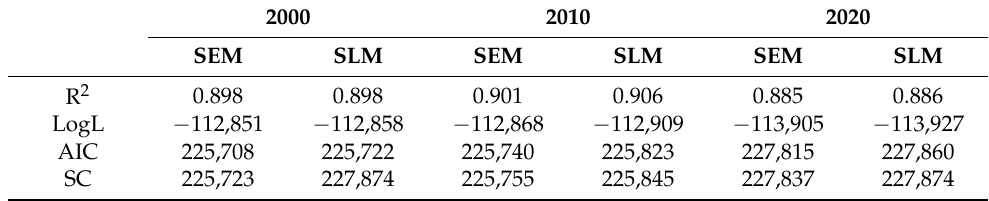
Table 9. Comparison of the goodness of fit between the spatial error model and the spatial lag model.